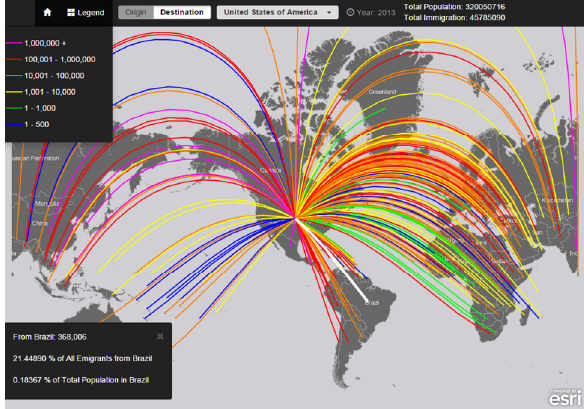
Figure 3 Web user interface for the global inter-country migration